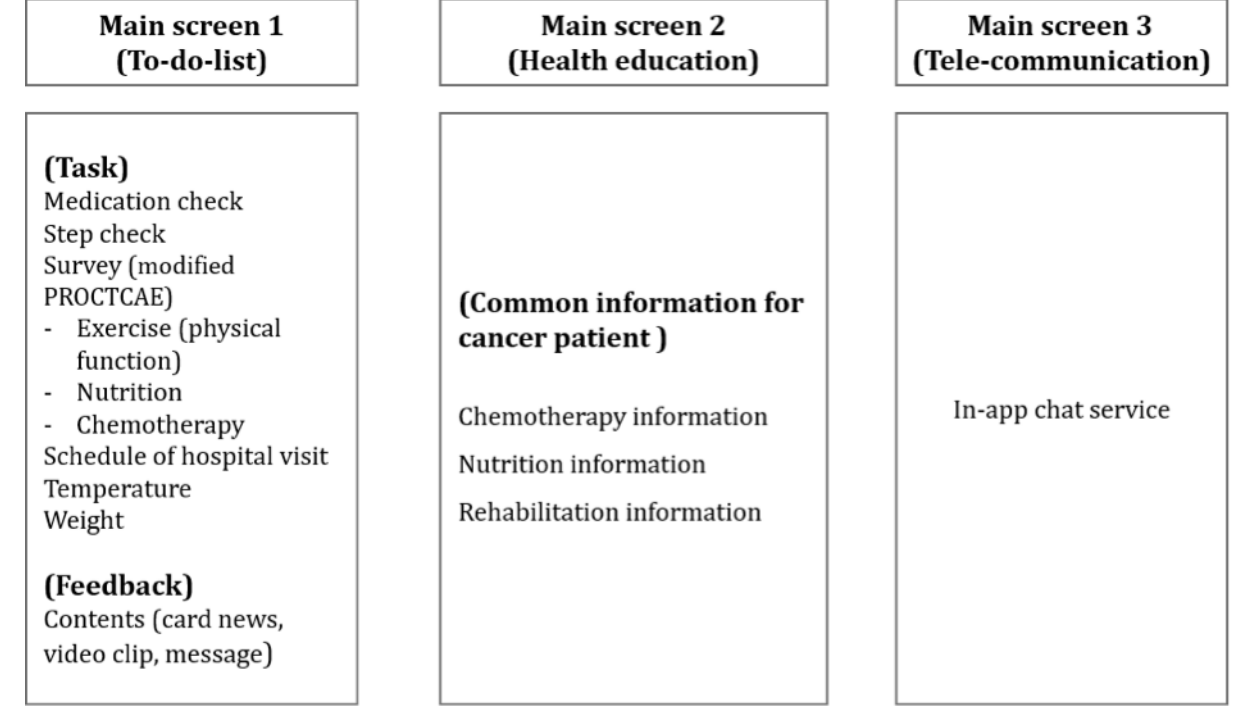
Figure 3. General concept of the Life Manager. The app has 3 main screens. Screen 1 shows the To-Do list theme, screen 2 depicts the Health education theme, and screen 3 shows the Telecommunication (In-app chat) theme. PRO-CTCAE: Patient-Reported Outcomes version of the Common Terminology Criteria for Adverse Events.